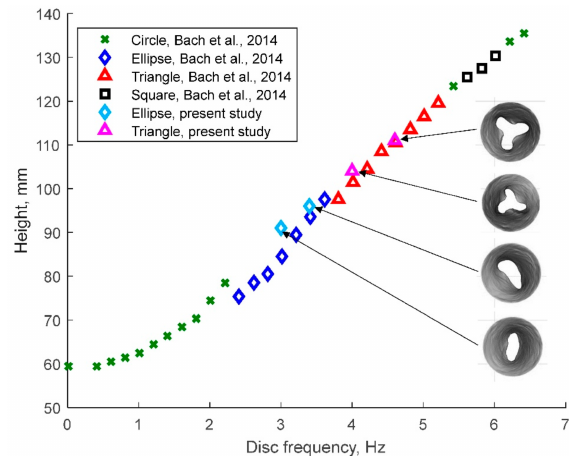
Figure 3. Circumferentially and time-averaged water height, simulated in the present study, vs. measurements from the